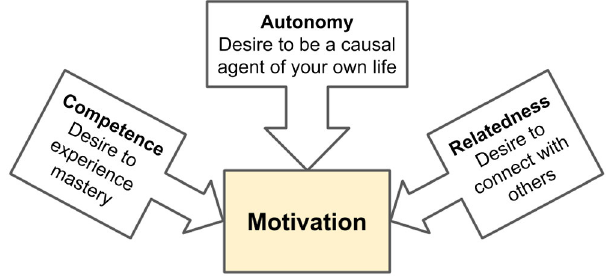
FIG. 4. The three innate psychological needs that lead to motivation in self-determination theory